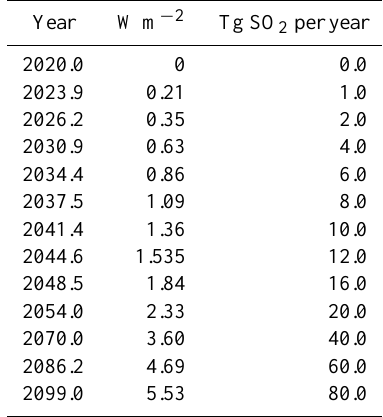
Table 1. Global average radiative forcing from a stratospheric sul- fate aerosol cloud needed to counteract the anthropogenic radiative forcing from the RCP8.5 scenario (Niemeier et al., 2013). The third column shows the stratospheric aerosol emission rate per year re- quired to produce this radiative forcing, in TgSO 2 yr − 1 , although the aerosols are sulfuric acid droplets. The rapidly increasing bur- den to counteract radiative forcing illustrates the disproportionate increase in sulfur emissions of greater than 2Wm − 2 due to ef- fects of aerosol growth and removal processes and therefore demon- strates the limitations of stratospheric aerosol geoengineering. The uncertainty of these values drastically increases with increasing emission values larger than 10TgSO 2 per